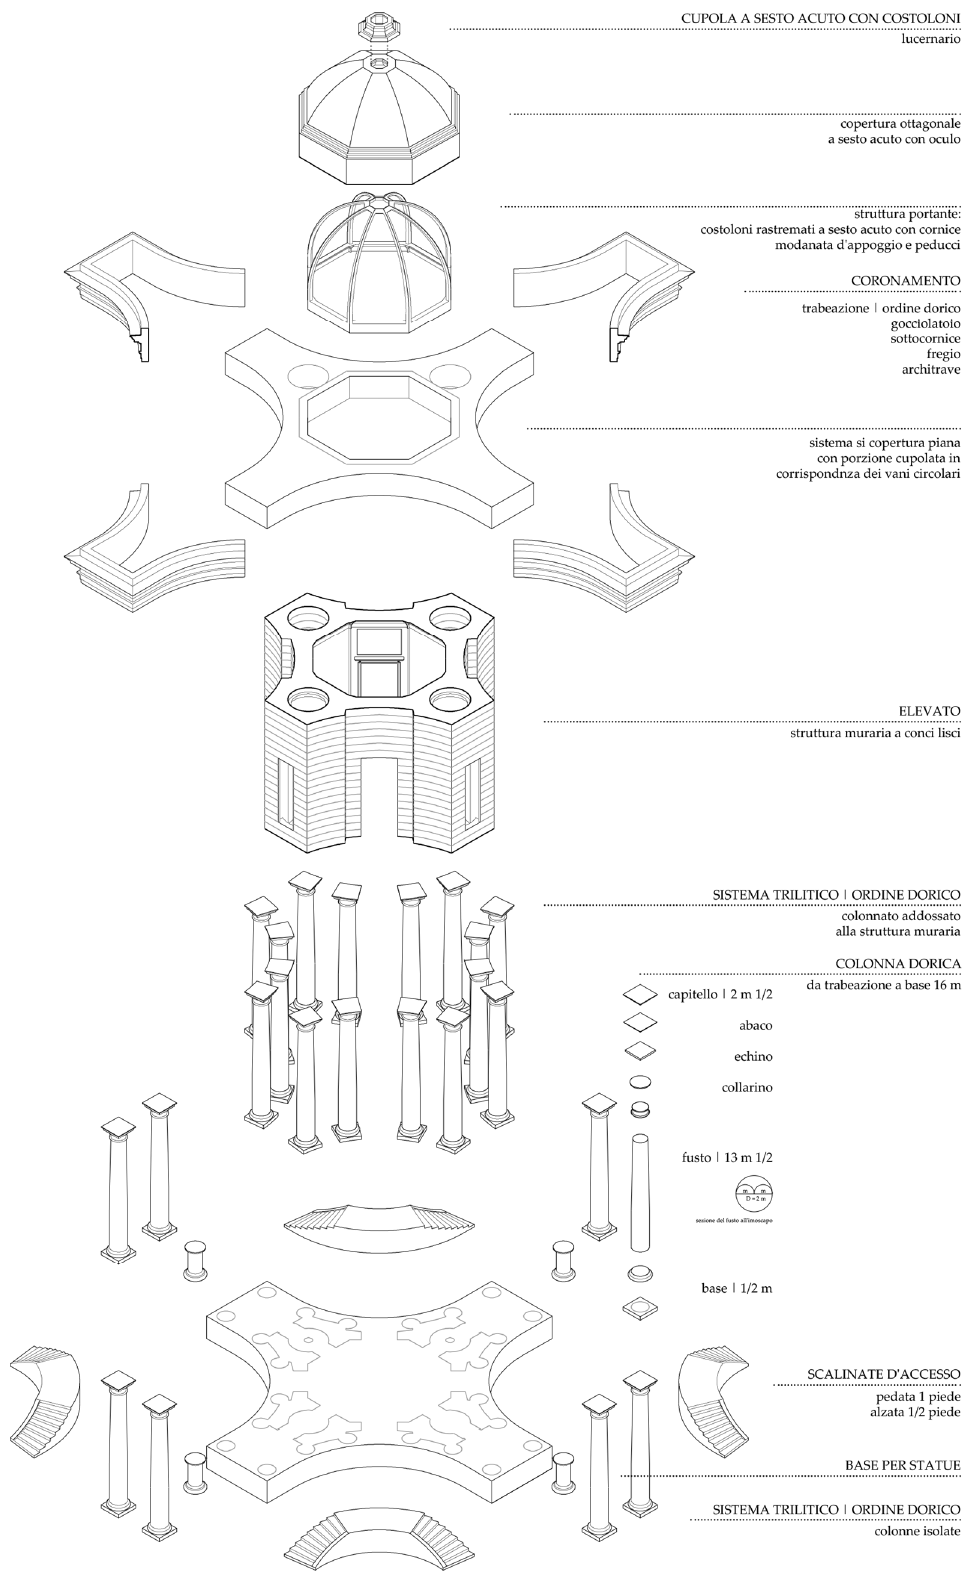
Figure A3. Axonometric exploded view of the temple